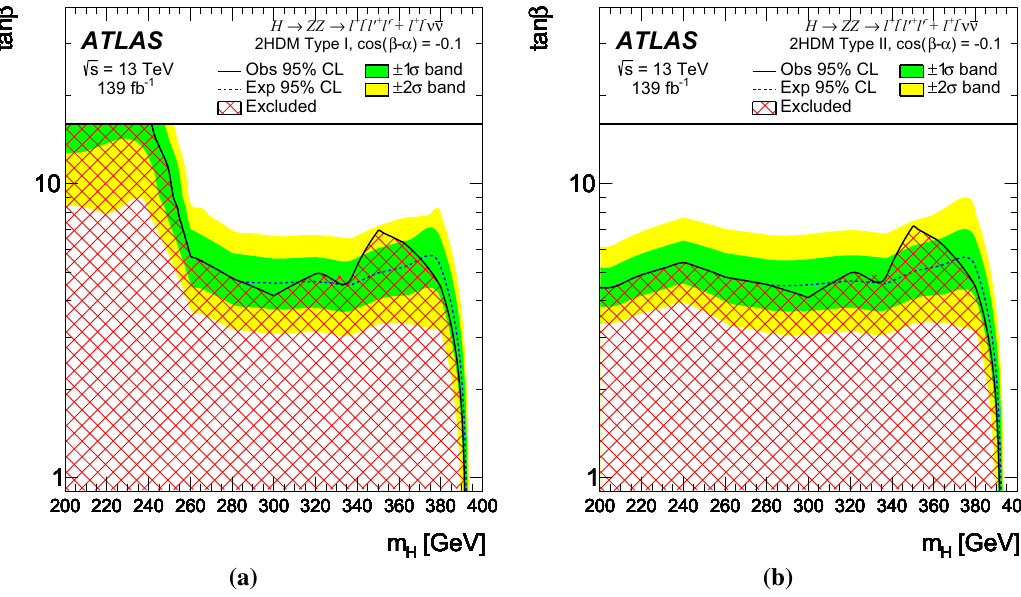
Fig. 7 The exclusion contour in the 2HDM a type-I and b type-II models for cos (β − α) = − 0 . 1, shown as a function of the heavy scalar mass m H and the parameter tan β . The green and yellow bands represent the ± 1 σ and ± 2 σ uncertainties in the expected limits. The hatched area shows the observed